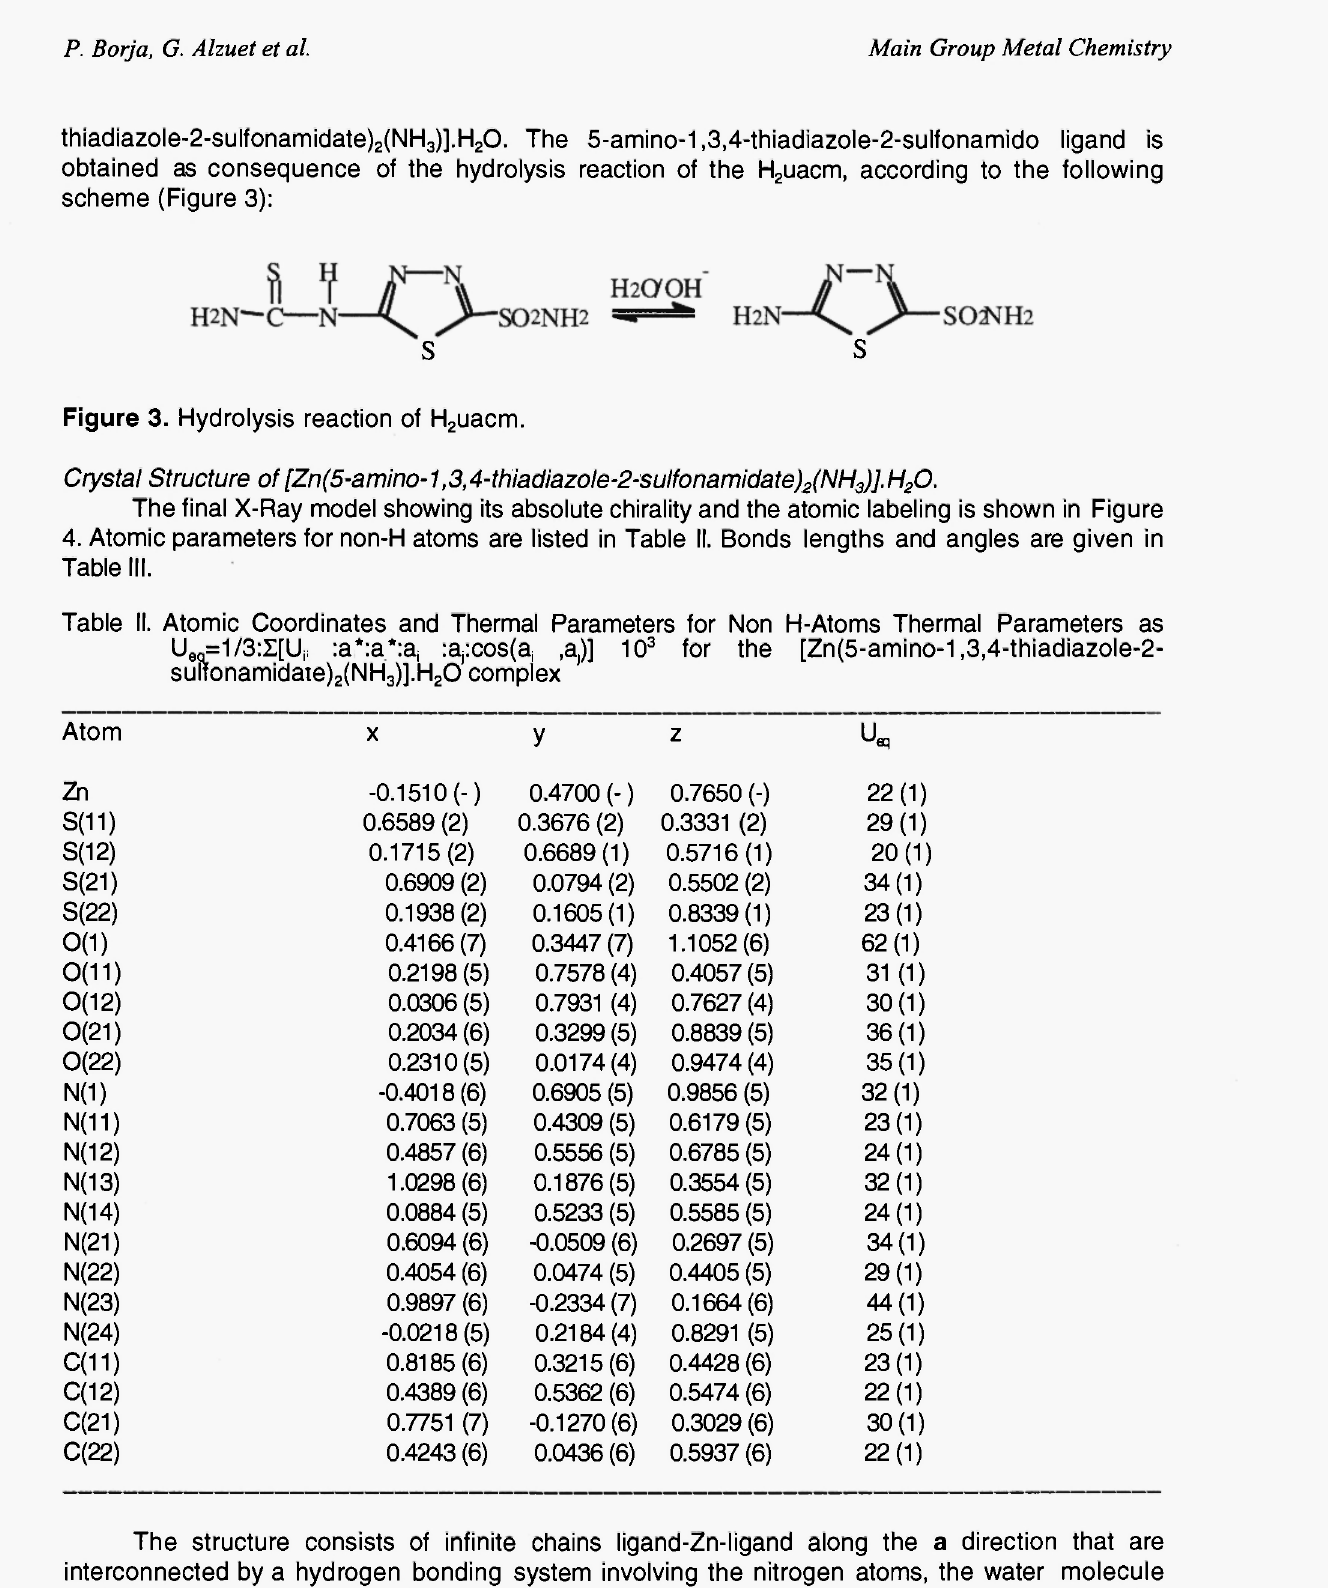
Figure 3. Hydrolysis reaction of H 2 uacm.